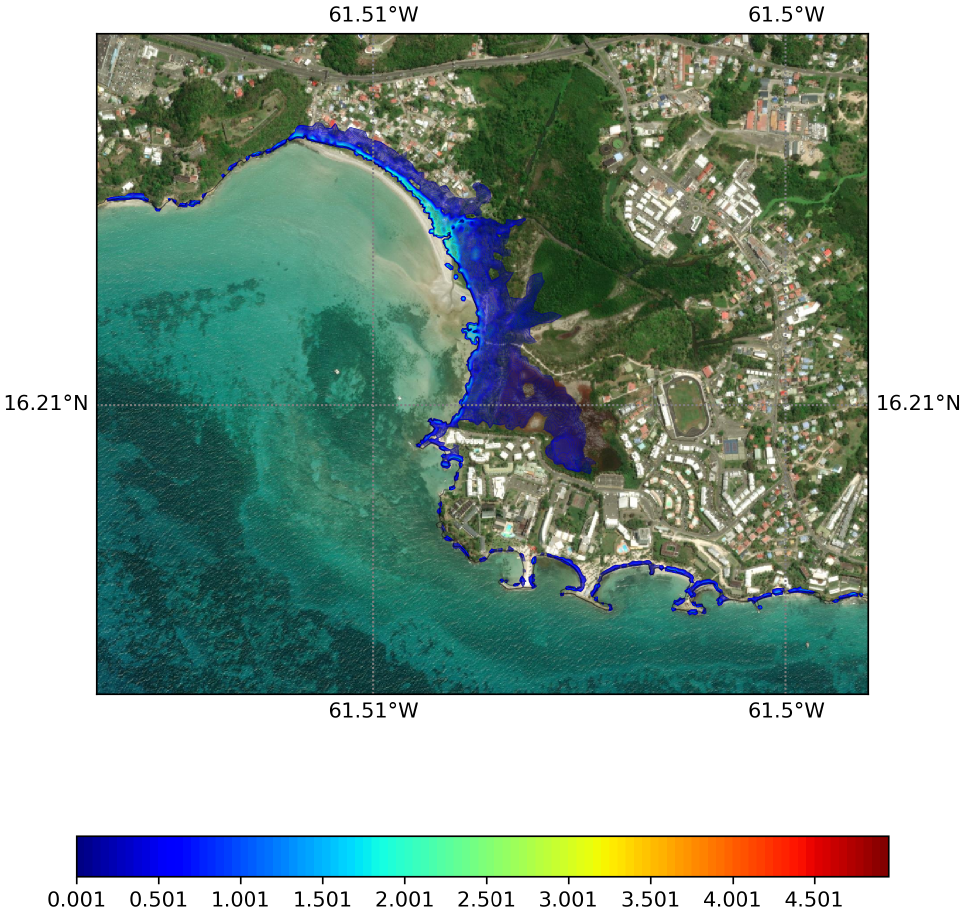
Figure 8. Maximum water depth in Grand Baie, Grande-Terre for the 40 km 3 scenario in the present